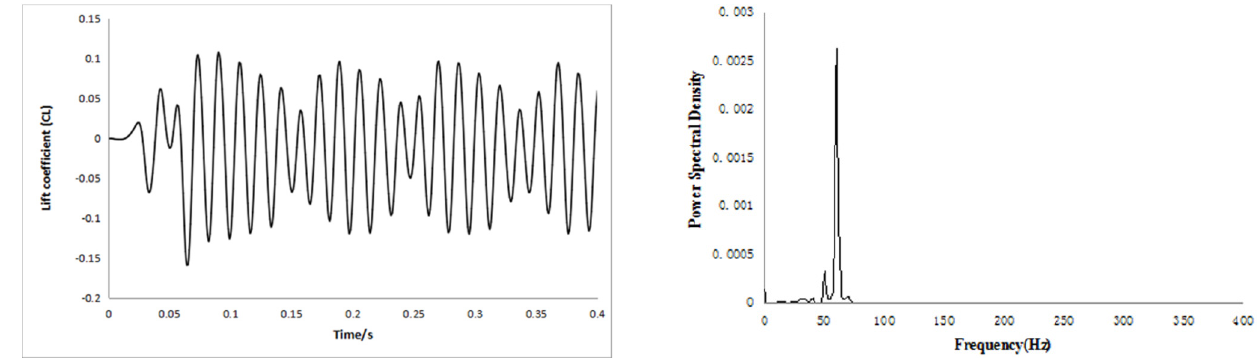
Figure 4. The lift coefficient time history curve and power spectrum curve of the vibration area under the 120% operation mode.